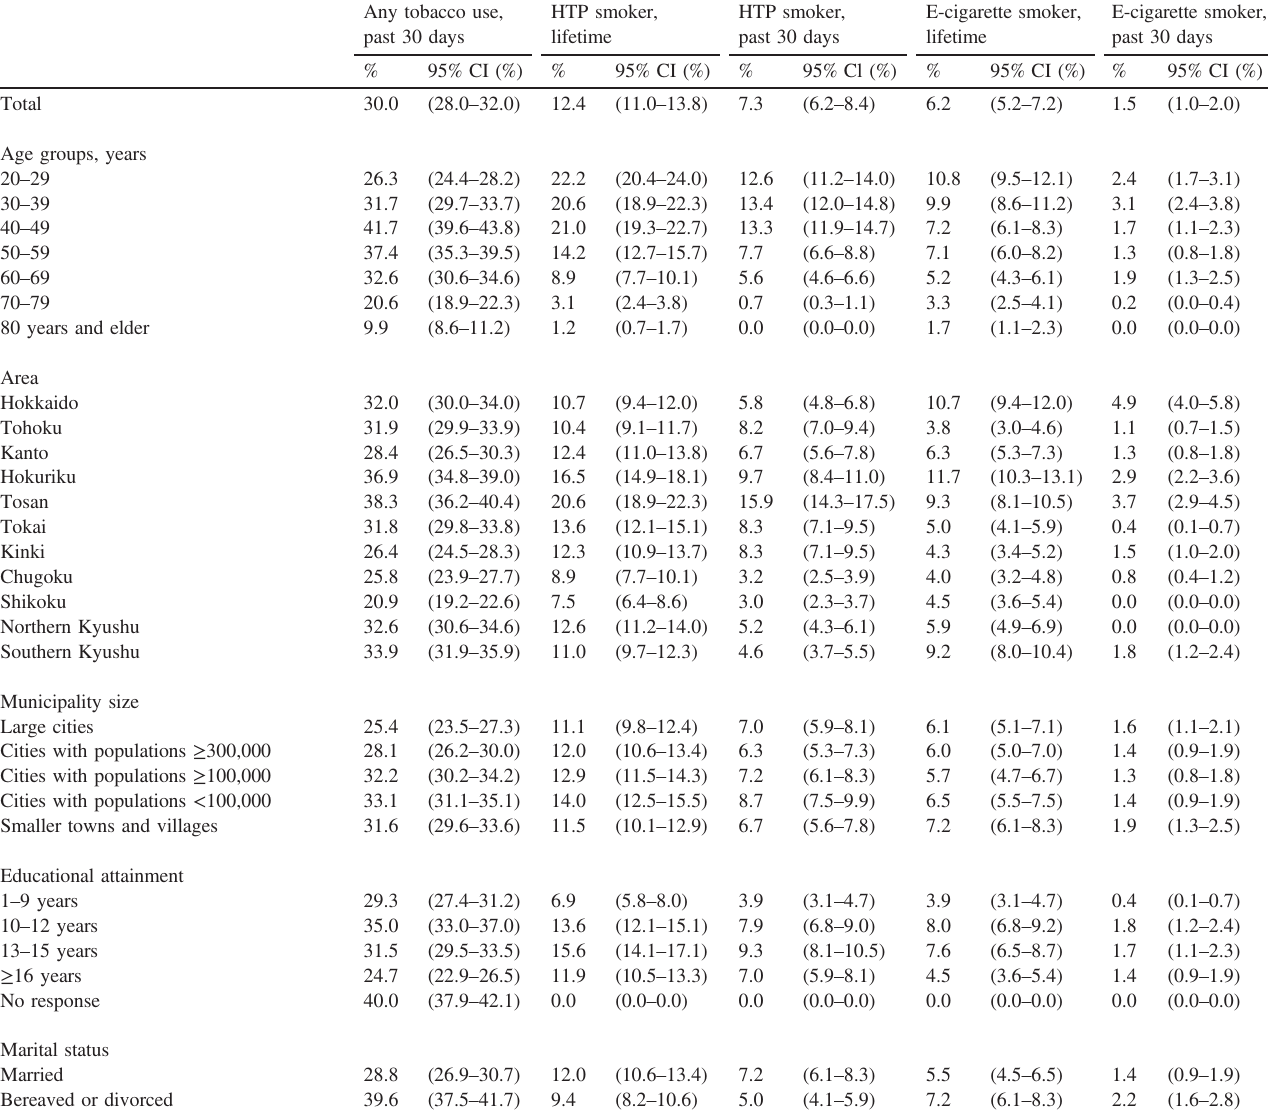
Figure 1. Proportions of tobacco smoking habits in Japan Table 3. Male tobacco smoker types by sociodemographic